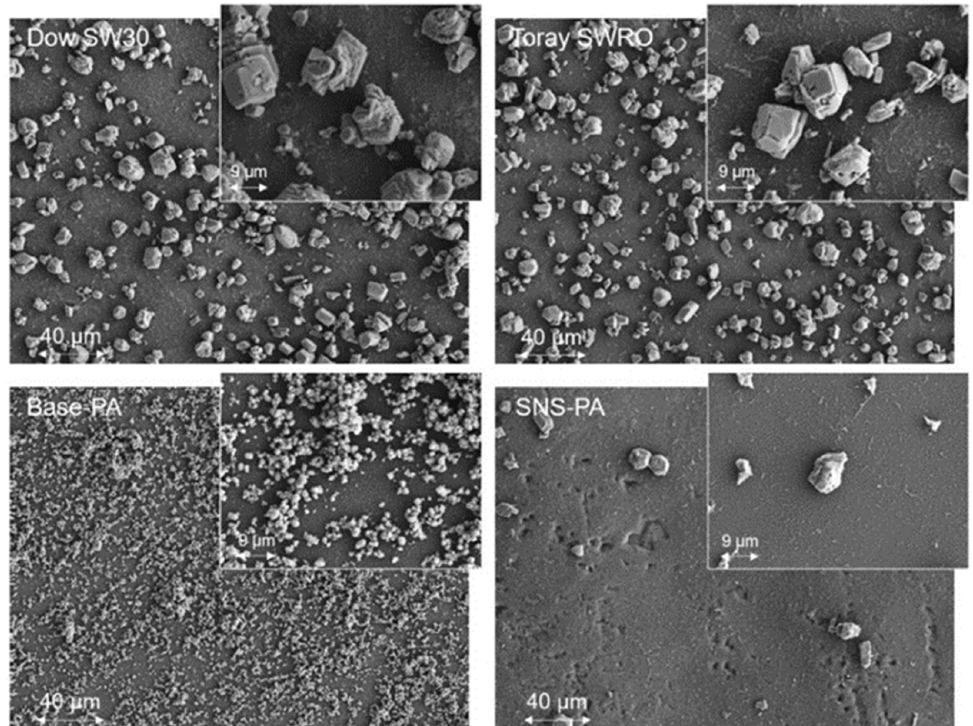
Figure 5. SEM top-view images of the SNS-PAA-PA and commercial membranes (Dow SW30, Toray SWRO, and base-PA) after D.I. water cleaning of membranes that were scaled with calcium carbonate over a 24 h scaling test. Calcite surface scale coverage (%) in the imaged zones: 40.5%, 59.9%, 57.8%, and 4.3% for the Dow SW30, Toray SWRO, base-PA, and SNS-PAA-PA membranes, respectively. (Note: all images were taken at a distance of 5.4 cm from the RO channel entrance (equivalent to image Figure 4c).